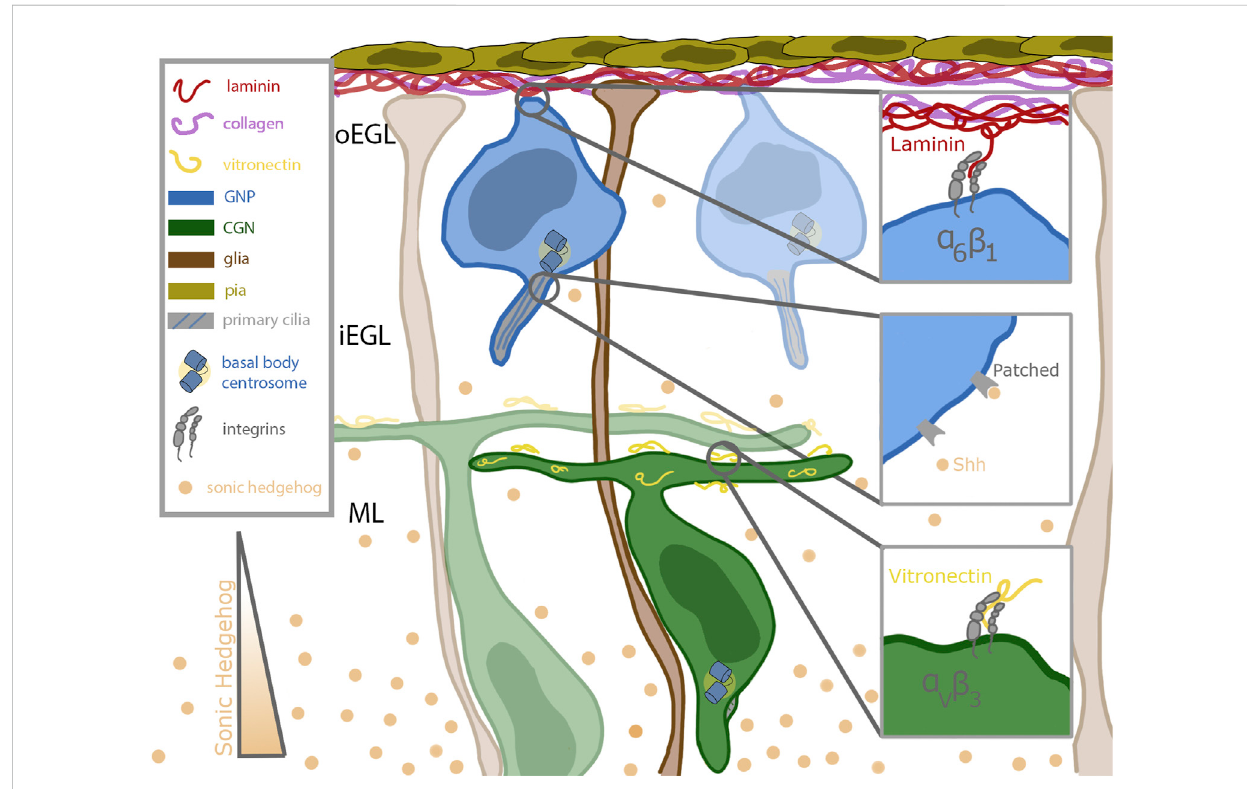
FIGURE 1 Schematicofcerebellargerminalzoneniche.Progenitorcells(showninblue)aresituatednearthetopofthegerminalzone,whichisenrichedinpia secreted laminin (red) and collagen (purple). The progenitors remain anchored to the laminin through their focal adhesions enriched with alpha 6 beta 1 integrins. Sonic hedgehog (Shh, in tan) binds to the patched receptor which is localized to the primary cilia of the progenitor cell. Shh is secreted by mature differentiated granule neurons and diffuses past the differentiated cells towards the progenitor cells. After differentiation, the granule neurons extend parallel fi bers and migrate inward along the bergmann glial fi bers (shown in brown) which extend all the way through the germinal zone to the laminin coated basement membrane. The parallel fi bers of differentiated neurons are coated with vitronectin (in yellow), a potent signaling molecule which promotes differentiation and blocks ciliogenesis. Vitronectin is secreted by both the Purkinje cells and fully differentiated granule